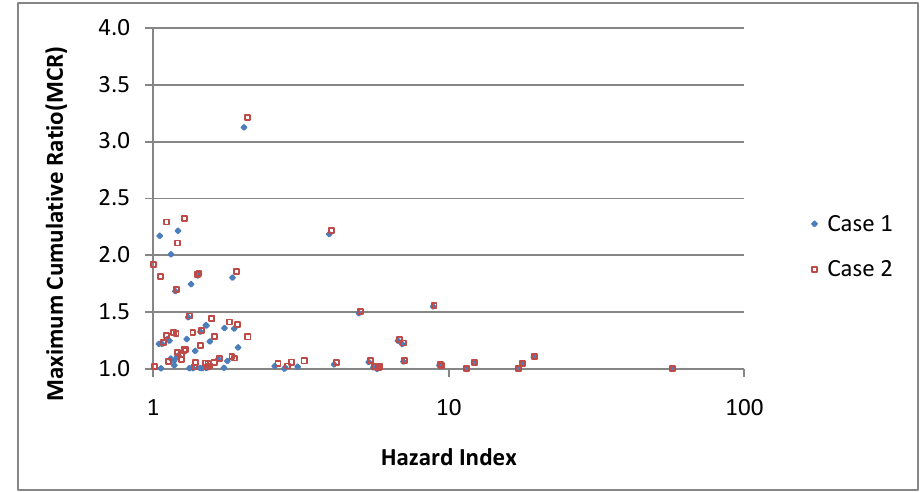
Figure 7. Plot of MCR and HI values for samples with HI greater than 1. HI and MCR are negatively correlated, Kendall’s tau-b values of –0.22 (p < 0.001) for Case 1 and values of –0.30 (p < 0.0001) for Case